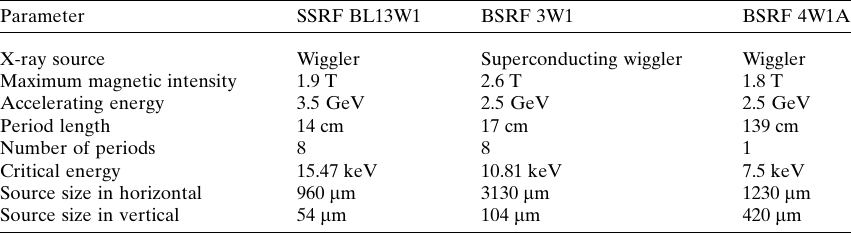
Table 1 Design parameters of the SSRF BL13W1 beamline, the BSRF 3W1 beamline and 4W1A beamline; the source size is the full width at half-maximum (FWHM) of the electron beam at the wiggler.